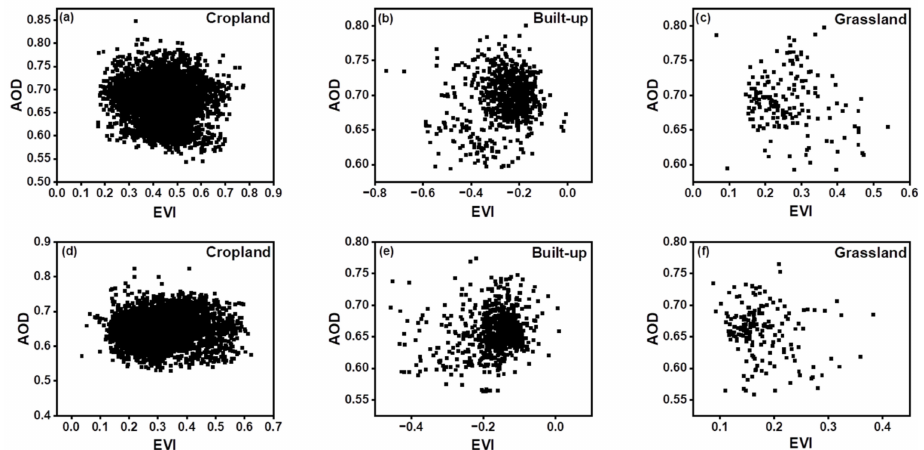
Figure 11. Scatterplot depicting the relationship between EVI and AOD (Aqua ( a – c ), & Terra ( d – f )) values for different LULC classes.